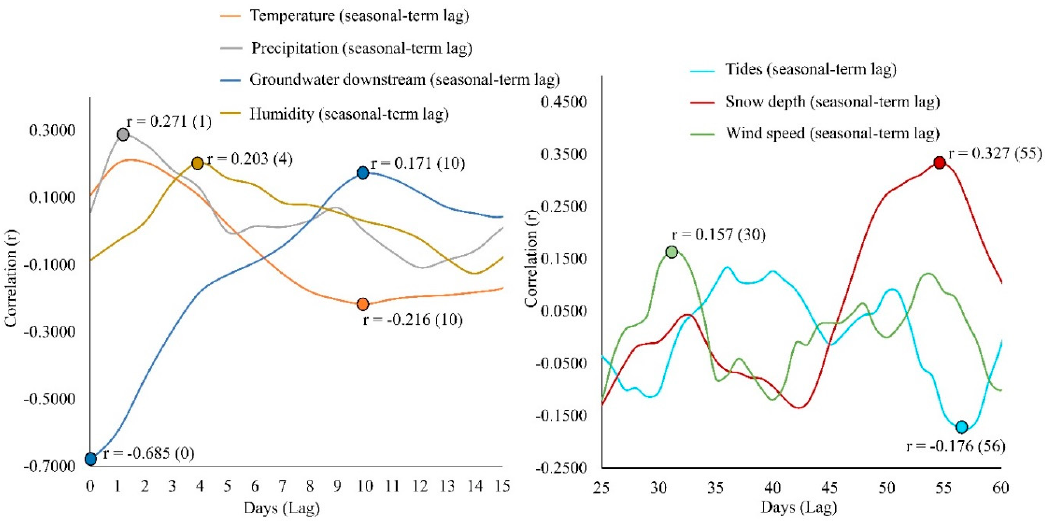
Figure 7. Determination of the appropriate lag time between the seasonal water discharge and the predictor variables. The graph on the left depicts the variables that had lag from 1 to 15 days, and on the right from 25 to 60 days. The strongest correlation between the predictor variables and the water discharge is equal to − 1 or 1, while the weakest is equal with 0. The shaded points represent the strongest correlation value.